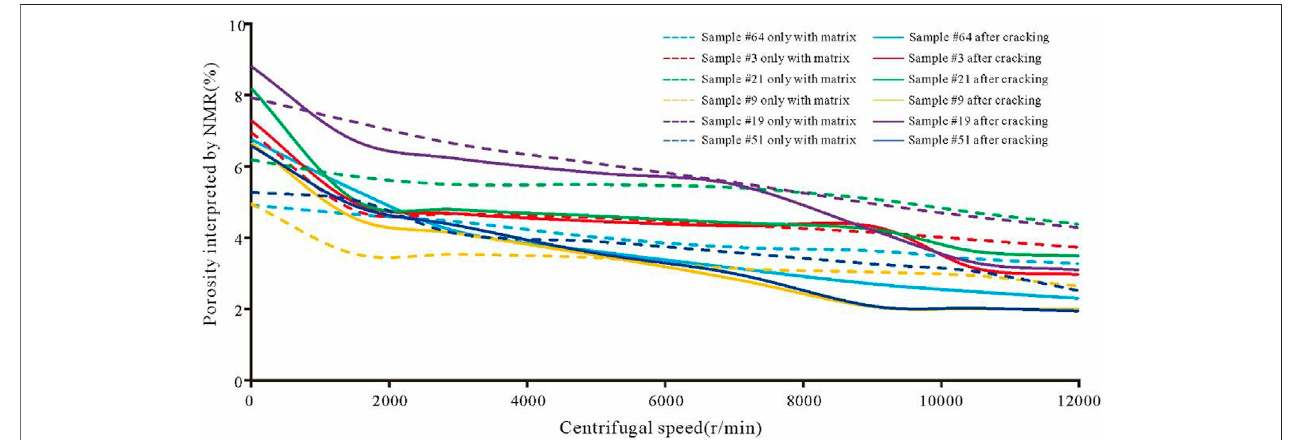
FIGURE 9 | Relationship between centrifugal speeds and porosity interpreted by NMR before and after cracking.